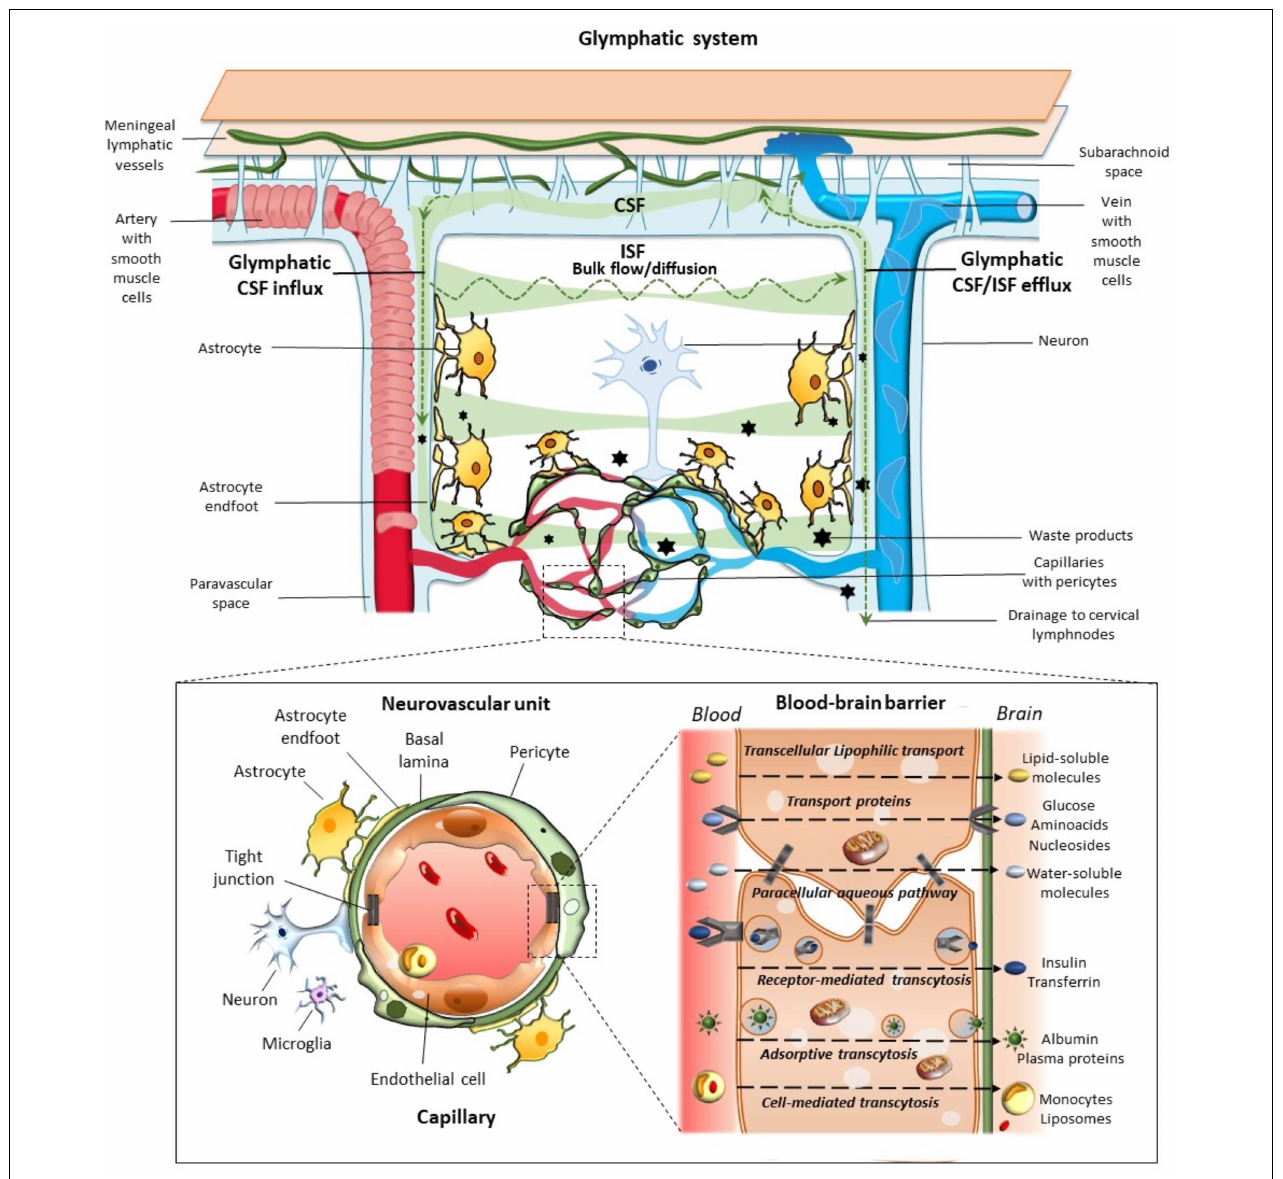
FIGURE 1 | Glymphatic system, neurovascular unit (NVU), and the blood–brain-barrier. The glymphatic system contributes to the transport of nutrients and signaling molecules into the brain parenchyma meanwhile promoting the clearance of proteins and interstitial waste solutes out of the brain. Subarachnoid CSF enters the brain parenchyma via para-arterial spaces and then mixes with the interstitial fluid (ISF) and waste solutes in the parenchyma. Whether this occurs through convective bulk flow or diffusion remains debated. The resulting CSF-ISF fluid exchange and the interstitial waste solutes enter the paravenous space through gaps between the astrocytic end-feet to be drained either back to the CSF-dural sinus-meningeal lymphatic vessels, or to the deep cervical lymph nodes. Green arrows and shades indicate the CSF and CSF-ISF fluid transport, while black stars indicate the interstitial waste solutes that exit the parenchyma via the paravenous efflux pathway. The insert depicts the main components of the NVU at the level of intraparenchymal capillaries, including perivascular astrocytes with their end-feet, neurons, microglia, pericytes, endothelial cells (ECs), and basement membrane (basal lamina). Capillary ECs are held together by tight junctions forming the blood–brain barrier (BBB), where the different transport routes are represented, including transcellular lipophilic transport, carrier protein-mediated transport, paracellular aqueous transport, receptor-mediated transcytosis, as well as adsorptive and cell-mediated